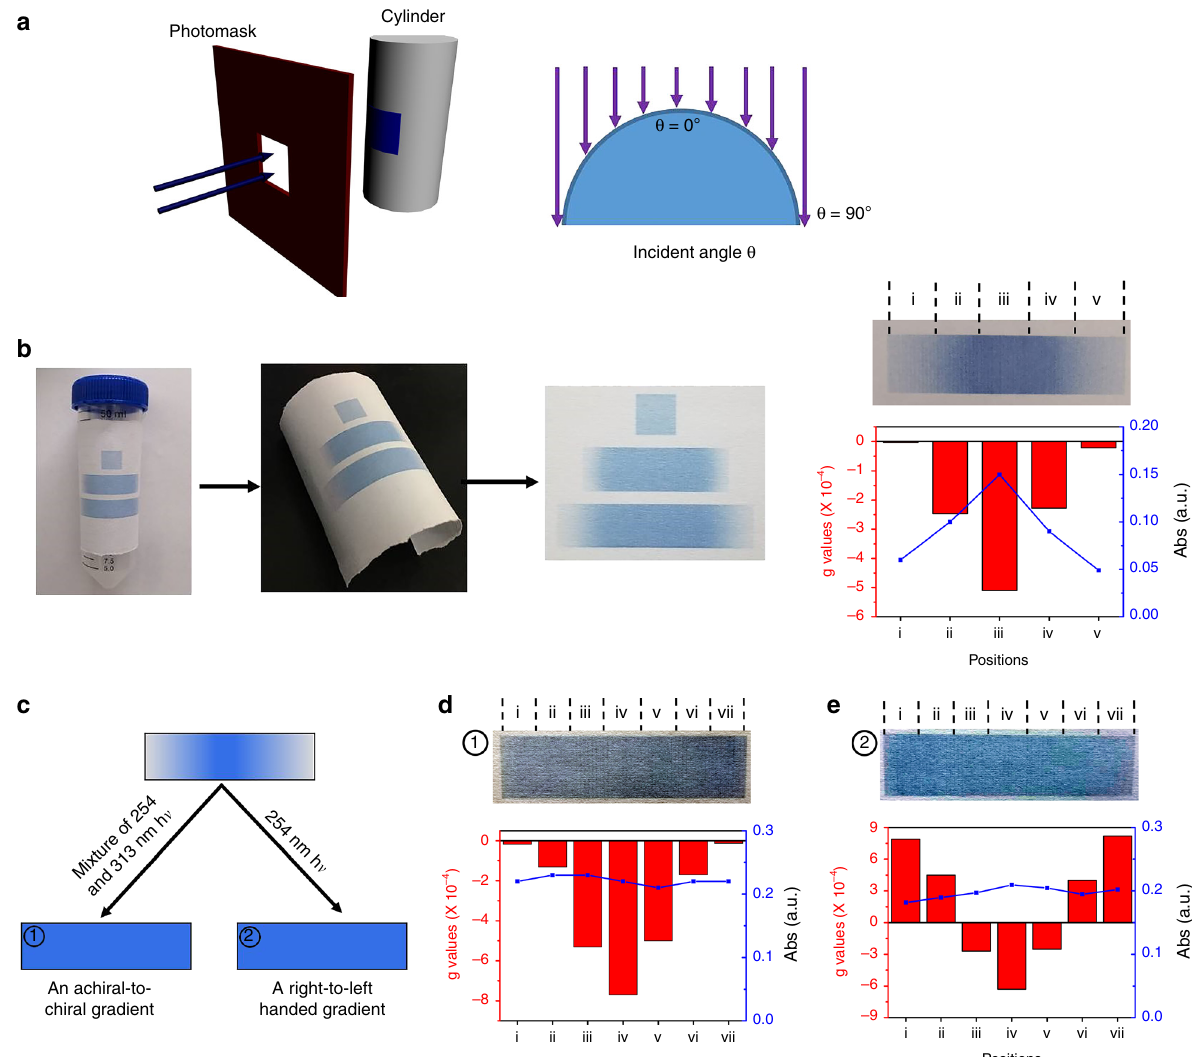
Fig. 6 Fabricating a continuous gradient of chirality by taking advantage of surface curvature. a Schematic of optical setup in which the incident angle varies with location. b Uneven distributions of PDA obtained due to uneven distributions of UV irradiation on the fi lm, when wrapped around a cylindrical object. A rectangular patch of PDA with chirality decreasing gradually from the center to the two edges, forming a smooth gradient, as proven by both its absorption and CD along the lateral locations. c Schematic of setup in which a second UV irradiation shining on the sample obtained in ( b ) to generate a seemingly uniform fi lm (same absorption) with varying chirality along the lateral locations. Two different gradients, an achiral-to-chiral gradient in ( d ) and a right-to-left-handed gradient in ( e ) are produced under two different irradiation conditions, ① and ② ,